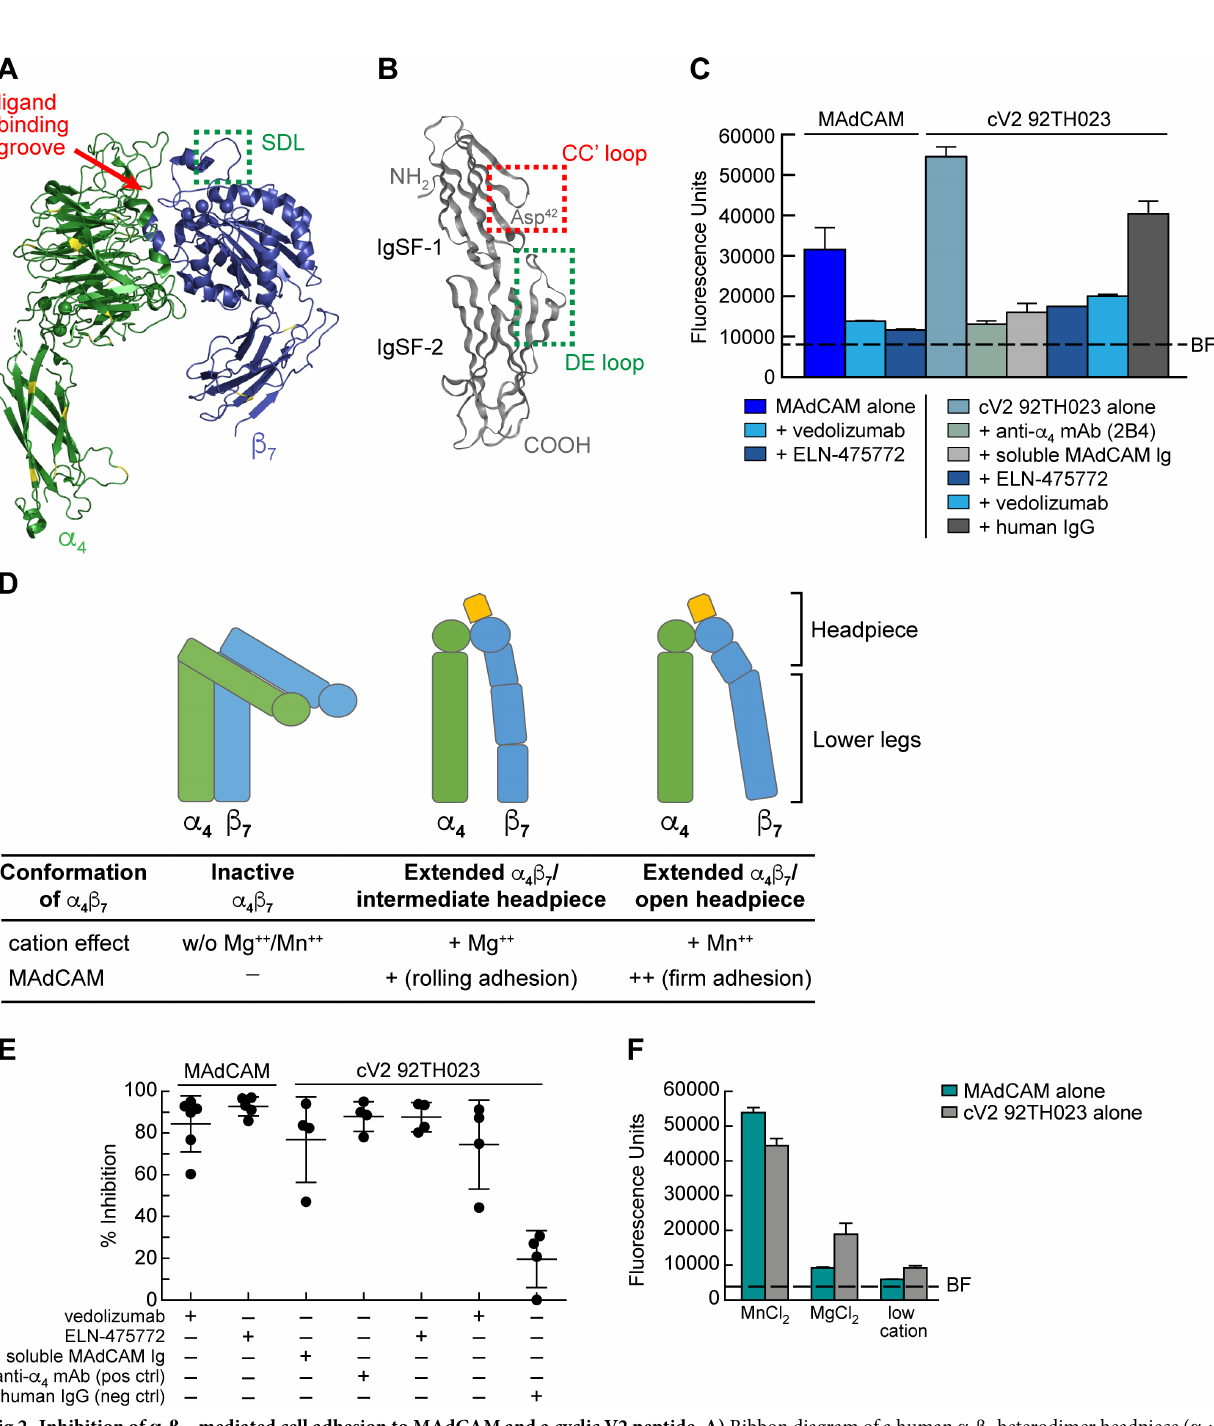
PLOS Pathogens| https://doi.org/10.1371/journal.ppat.1007278 August 28, 2018 7 /